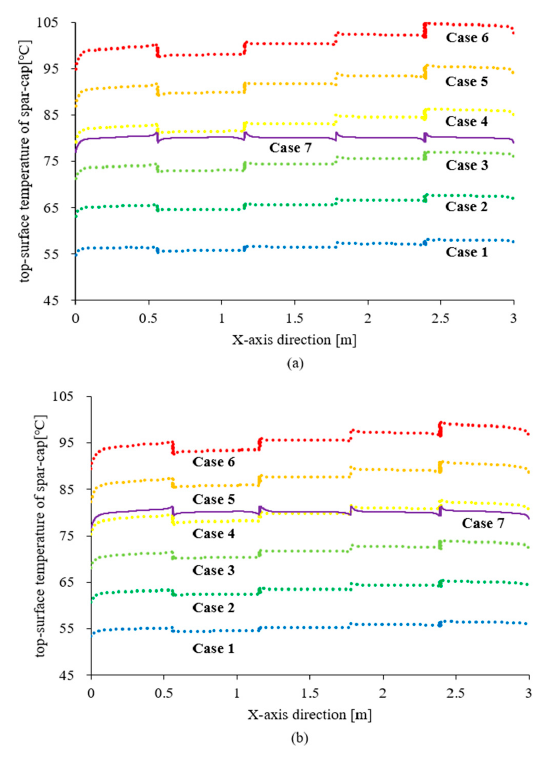
Figure 7. Top-surface temperature of spar-cap comparison between improvement model and the reference model on steady state analysis: ( a ) aluminum mold; ( b ) GFRP mold. reference model on steady state analysis: ( a ) aluminum mold; ( b ) GFRP